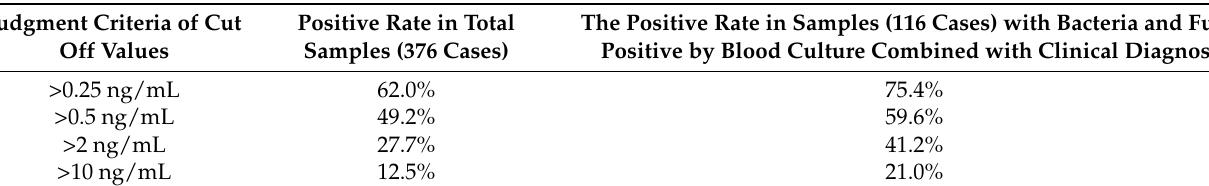
Table 5. Results of the positive rate in PCT judged according to different cut off values.